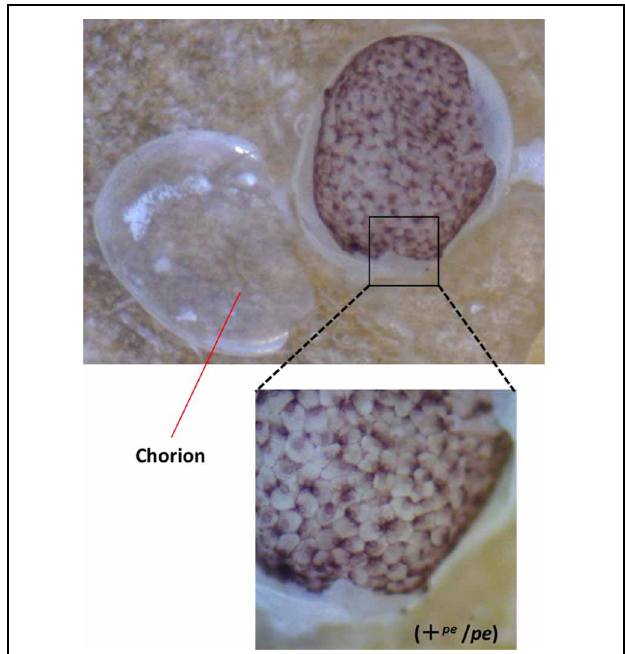
FIGURE 1 | Stereomicroscopic view of serosal cells in the black egg. The genotype of the black egg is heterozygote for pe ( + pe / pe ). Chorion was removed from the